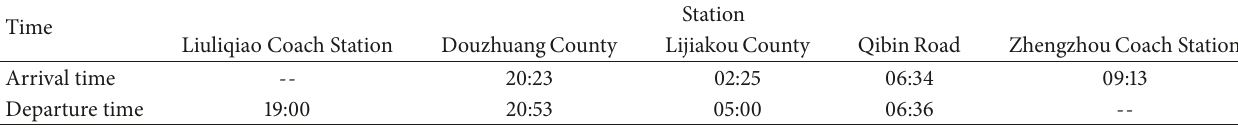
Table 4: Extracted schedule for Route 212.